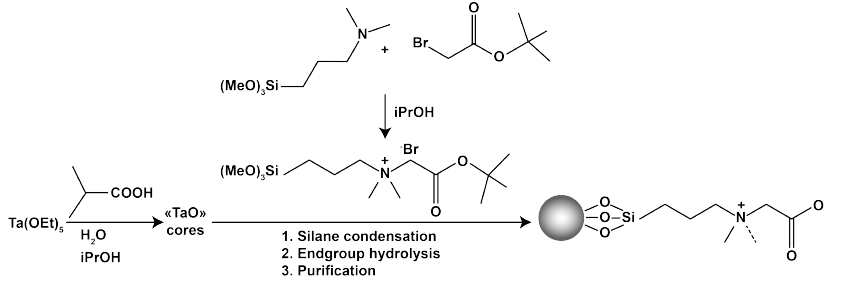
Figure 2. One of the mechanisms for creating tantalum powder for preparing a suspension consisting of an embolizing polymer and powder